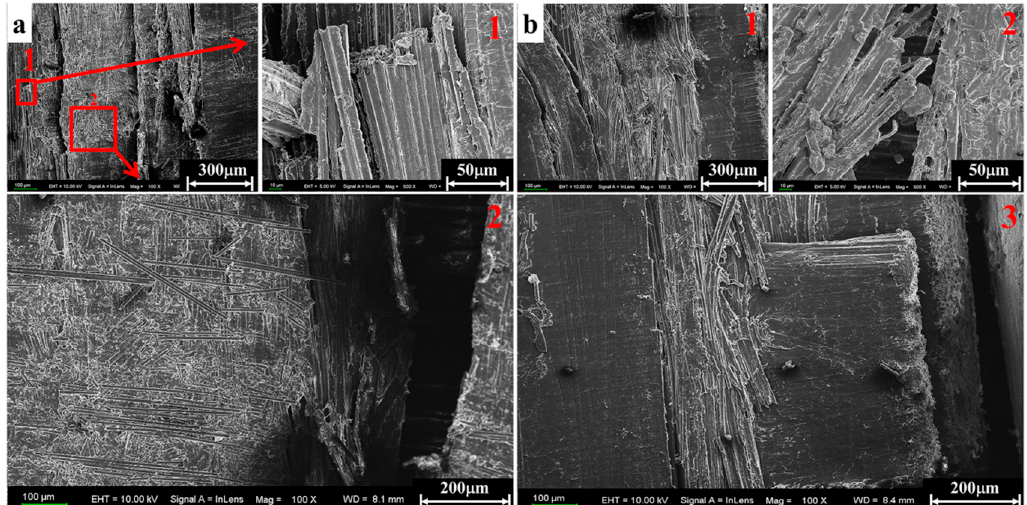
Figure 11. Surface morphology of the debris at a strain rate of 3866/s. ( a ) Failure characteristics of longitudinal and transverse fibers. ( b ) Tearing feature across layers.